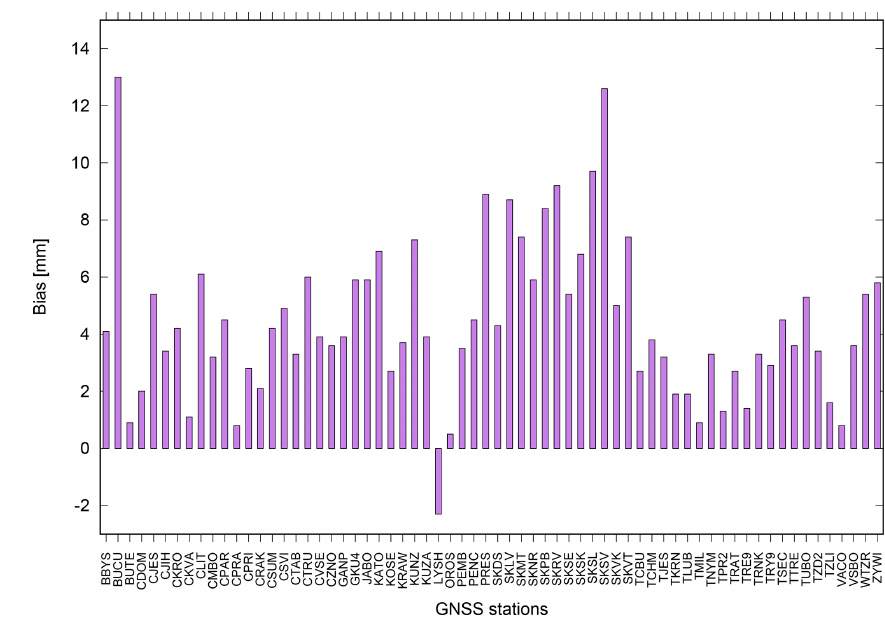
Figure 7. The ZTD bias in millimetres for GOP1 (purple) network calculated for the period of 15–31 May